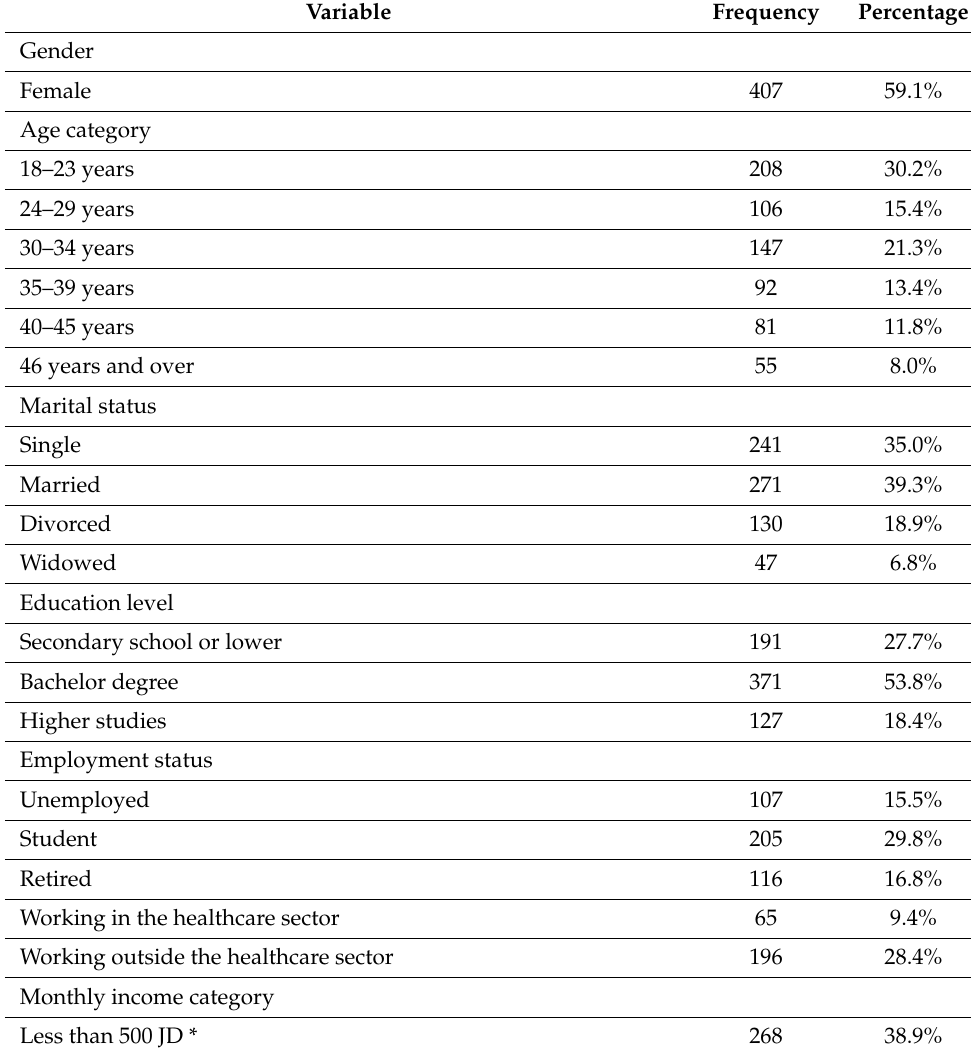
Table 1. Characteristics of the study